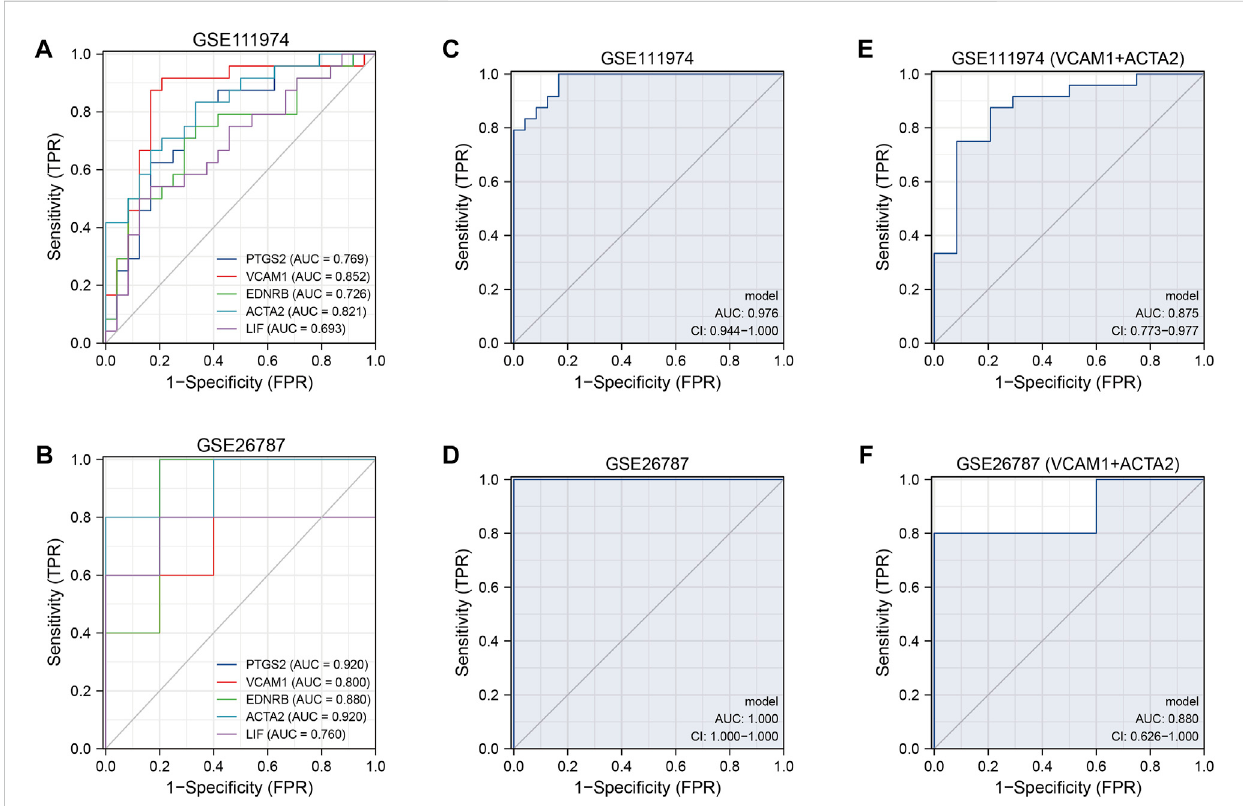
FIGURE 7 TheROCcurvesofthediagnosticmodel. (A,B) ThediagnosticROCcurvesofindependent fi vehubgenesinGSE111974 (A) andGSE26787 (B) . (C,D) The diagnostic ROC curves of combined fi ve hub genes in GSE111974 (C) and GSE26787 (D) . (E, F) The diagnostic ROC curves of combined VCAM1 and ACTA2 in GSE111974 (E) and GSE26787 (F) .